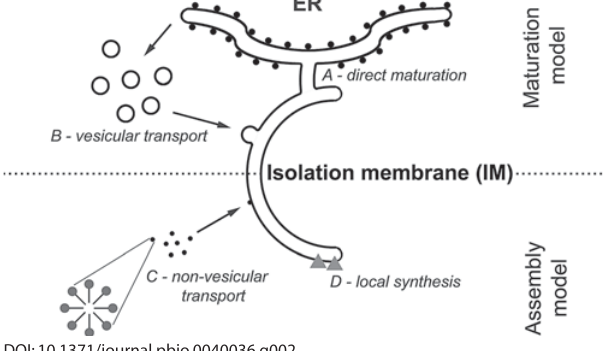
Figure 2. Possible Membrane Sources of the IM Some of the possible scenarios for IM formation are illustrated here. According to the maturation model, upon induction of autophagy, membrane may be directly derived from the ER by folding (A), or in the form of vesicular transport (B). In the assembly model, membrane may be assembled de novo at the site of IM formation, originating from nonvesicular transport, such as micellar, as shown in (C), or local synthesis (D). See text for further